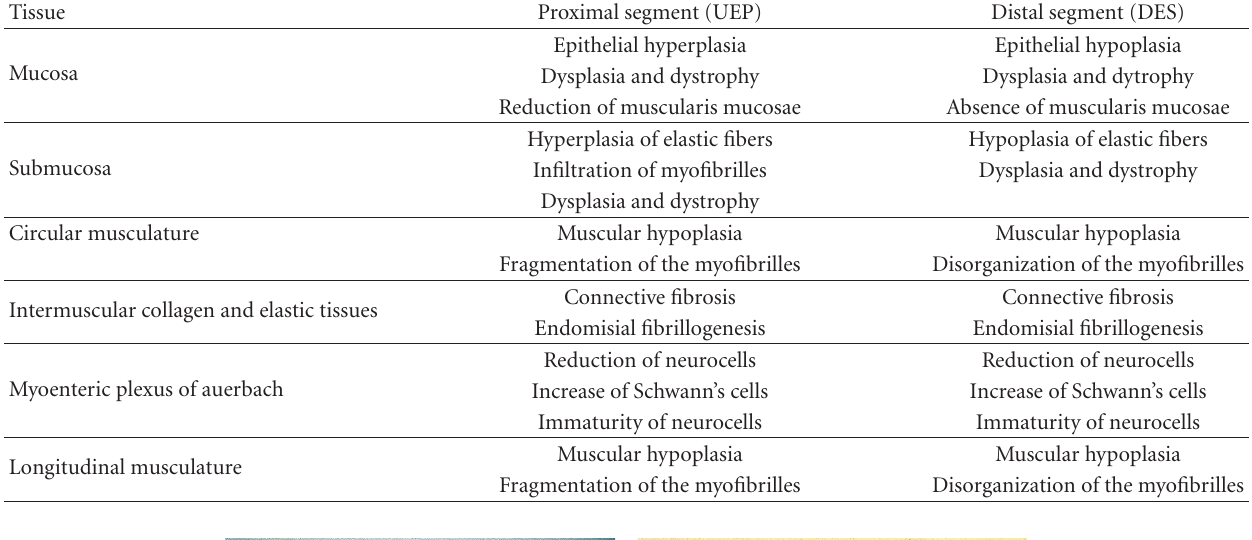
Table 1: Summary of morphologic and immunohistochemical findings of the esophageal segments in human EA/TEF.